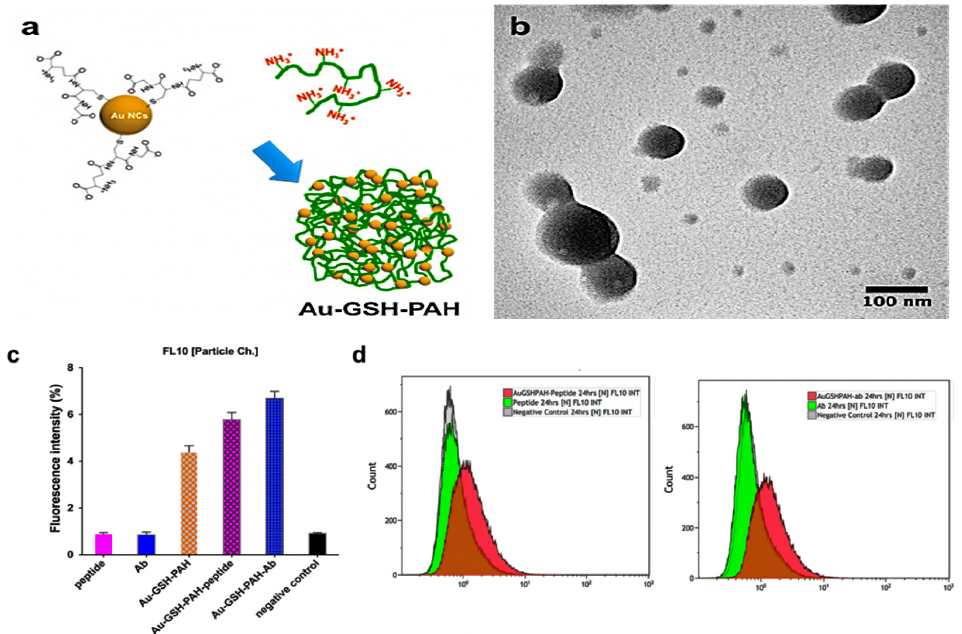
Figure 6. ( a ) Schematic representation of the synthesis of self-assembled Au NCs using a cationic polymer (PAH) and Au NCs stabilized by GSH, ( b ) TEM images of Au-GSH-PAH, ( c ) Detection of the fluorescence signal in cells from ( c , d ) the self-assembled Au NCs (Au NC fluorescence signal). Reprinted (adapted) with permission from ref [247]; Ammar et al., ACS Nano 10 (2016) 2591–2599. Copyright (2016) American Chemical Society.